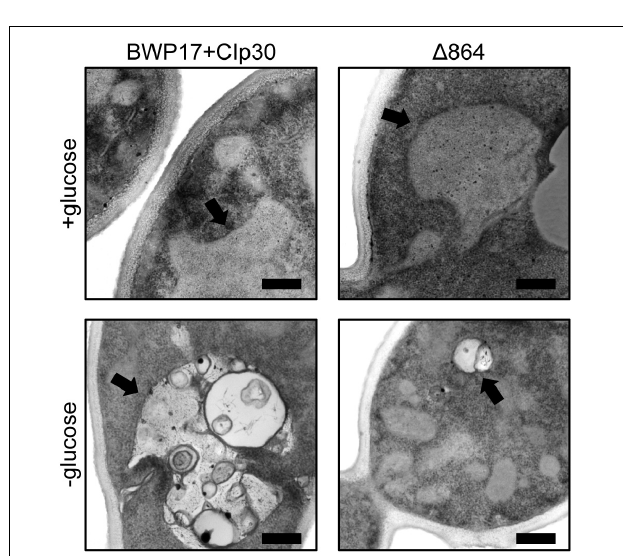
FIGURE 5 | Thin-section electron microscopy reveals differences in cell wall structure and vacuolar morphology in a Pma1p truncation mutant. Wild-type and (cid:49) 864 cells were grown for 16 h under glucose-replete and glucose-starved conditions, then examined via thin-section electron microscopy. In each panel, the black arrow is pointing to the vacuole. Scale bar indicates 400